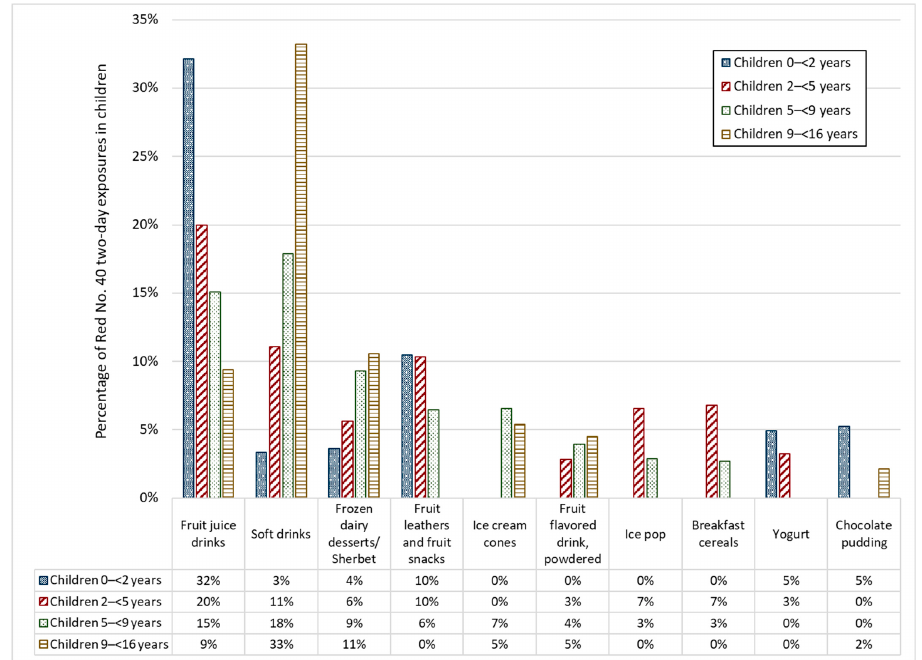
Figure 1. Top foods contributing to FD&C Red No. 40 two-day average exposure estimates in children aged 0–<16 years (typical-exposure scenario) who consumed at least one food containing Red No. 40. Int. J. Environ. Res. Public Health 2022 , 19 , x FOR PEER REVIEW